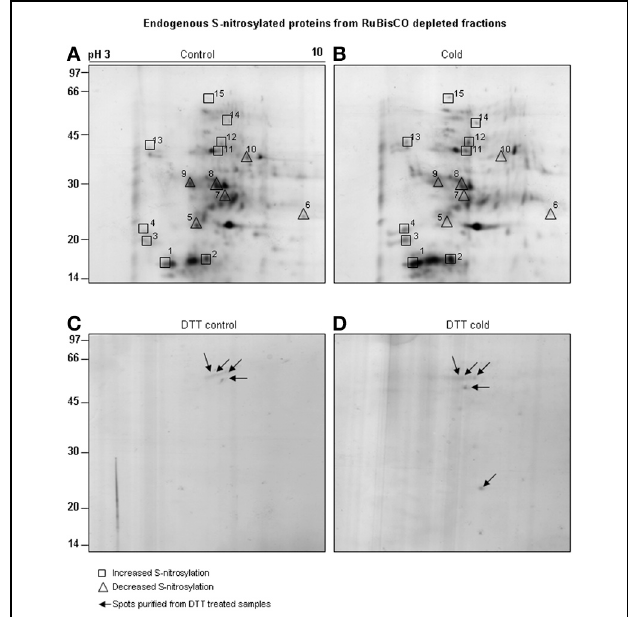
FIGURE 5 | Purification of cold responsive S-nitrosylated proteins. RuBisCO depleted proteins (5mg) from control (A) and cold (B) treated seedlings were subjected to BST and neutravidin affinity purification. Purified S-nitrosylated proteins were resolved on 2-D gel using non-linear IPG strips (13cm, pH 3-10) and 12% SDS-PAGE. As a control, RuBisCO depleted proteins from the control (C) and cold (D) seedlings were treated with DTT (10mM) and the purified spots were resolved on 12% SDS-PAGE (marked with arrows). Gels were stained using MS compatible silver staining and analyzed using ImageMaster 2-D Platinum software. Spots showing increased S-nitrosylation intensity after cold stress are marked with boxes and decreased S-nitrosylation by